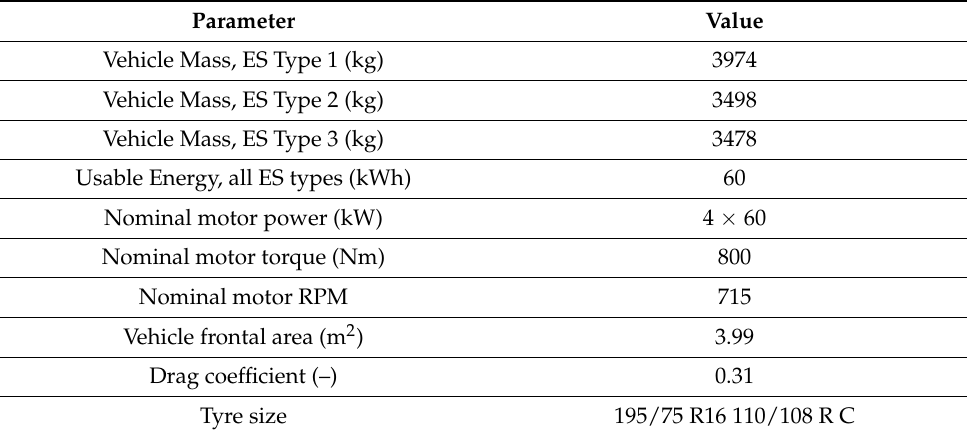
Table 3. Vehicle parameters.